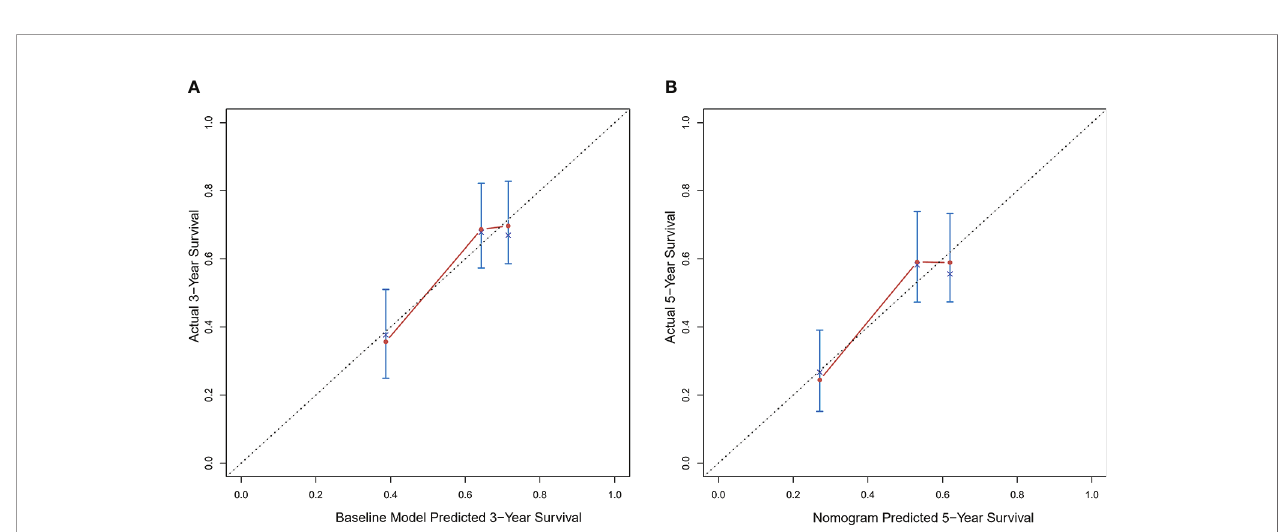
FIGURE 2 | Calibration curves of the prognostic monogram for the (A) 3-year overall survival (OS) and (B) 5-year OS in the training dataset.